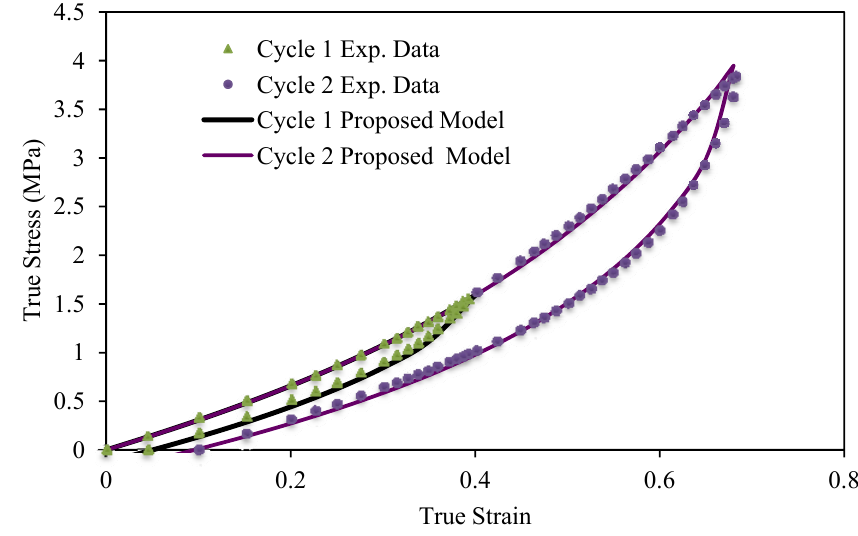
Figure 2. Theoretical predictions obtained from the proposed material model given by Equation (25) compared with experimental data for 12.2% of MWCNT. The estimated material parameter values are δ = 0.49, and C = 4